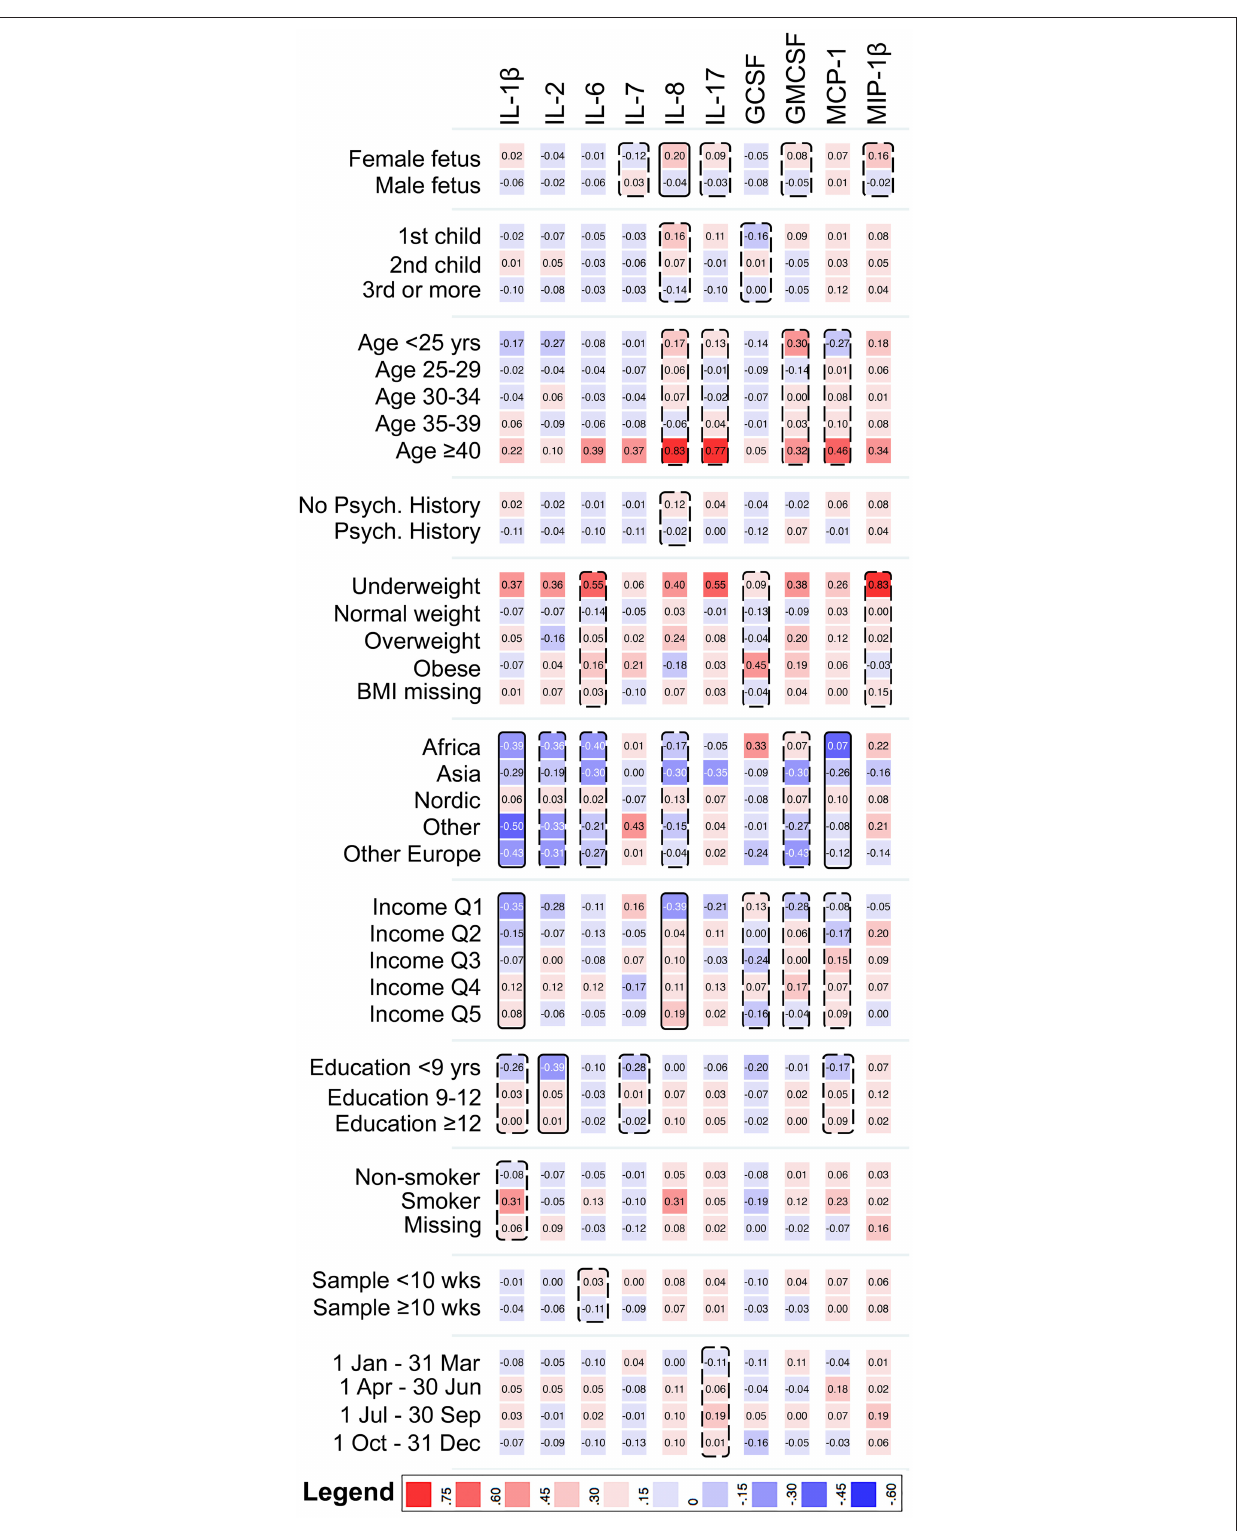
FIGURE 1 | Heat map showing the mean z-score of cytokines with < 70% imputed values, by categories of the covariates, among mothers to 429 unaffected individuals in the cohort. Solid boxes indicate that the cytokine is associated with the covariate at p < 0.05. Dashed boxes indicate that the cytokine is associated with the covariate at p < 0.20. IL-1 β , Interleukin-1 β ; IL-2, Interleukin-2; IL-6, Interleukin-6; IL-7, Interleukin-7; IL-8, Interleukin-8; IL-17, Interleukin-17; GCSF, Granulocyte Colony-Stimulating Factor; GMCSF, Granulocyte Monocyte Colony-Stimulating Factor; MCP-1, Monocyte Chemoattractant Protein 1; MIP-1 β , Macrophage Inflammatory Protein 1 β